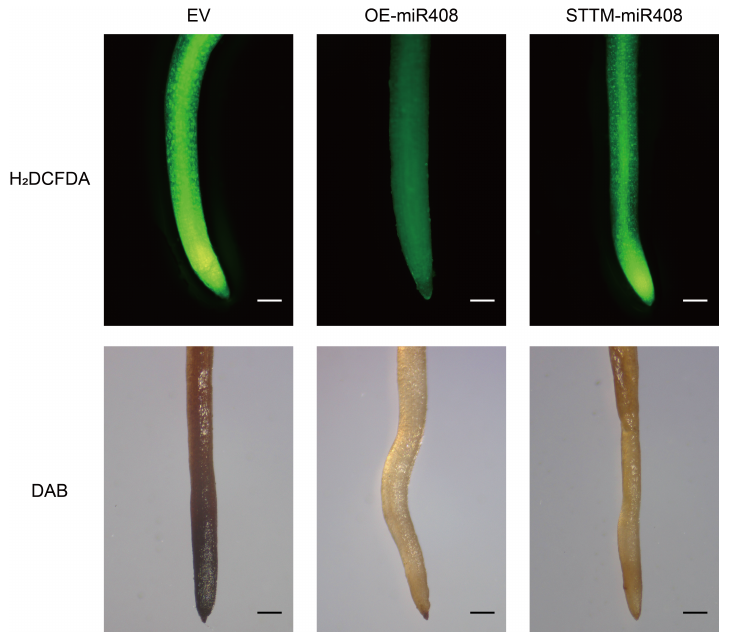
Figure 9. Detection of physiological and biochemical indicators of the OE- miR408 and STTM- miR408 soybean hairy roots. H 2 DCFDA probe labeling and DAB staining of Agrobacterium-mediated transient transformation of hairy roots. Bar = 100